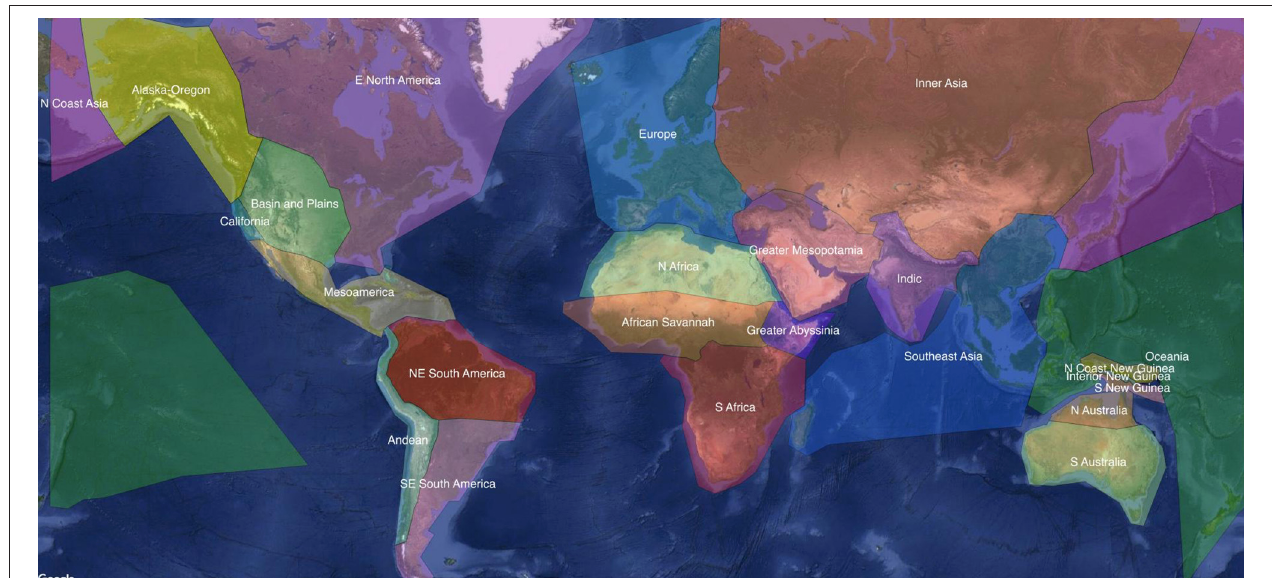
FIGURE 1 | The 24 areas of the AUTOTYP on a world map (Bickel et al., 2017; used under CC-BY 4.0 license).